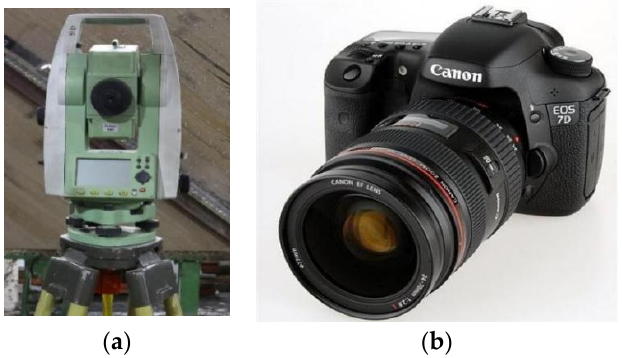
Figure 3. Monitoring equipment. ( a ) Optical total station, ( b ) high-speed camera.